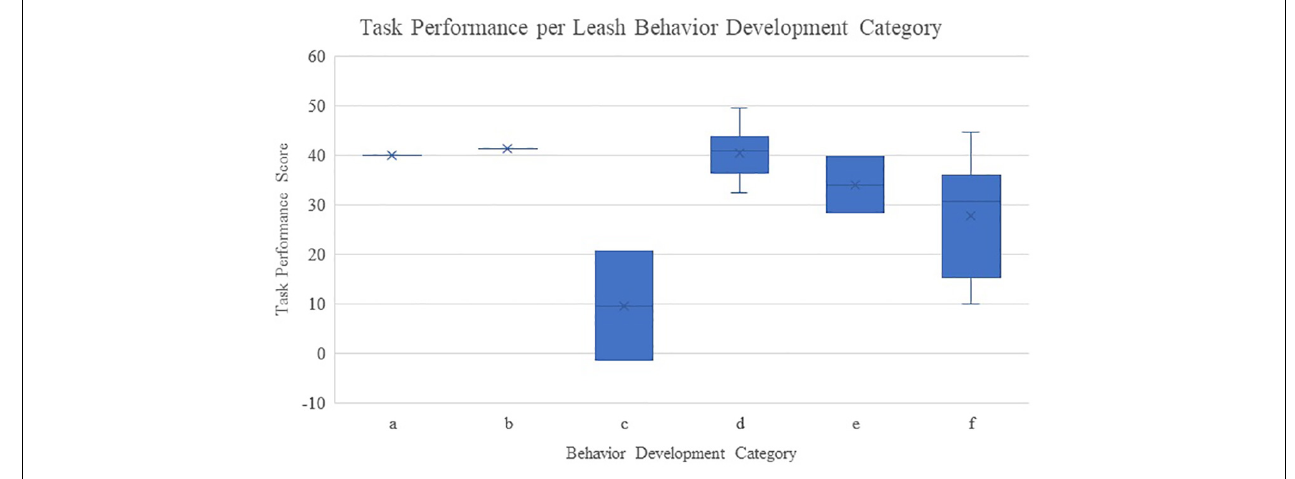
FIGURE 4 | An overview of the task performance of participants per category. For each participant, the average score of the four rounds was calculated. The categorization is based on which category participants were in when looking at their leash activity only: (a) mostly following, (b) start off following, leading in the middle, following at the end, (c) start off following, increase of leading over time, (d) start off leading, increase of following over time, (e) start off leading, following in the middle, leading at the end, (f) mostly